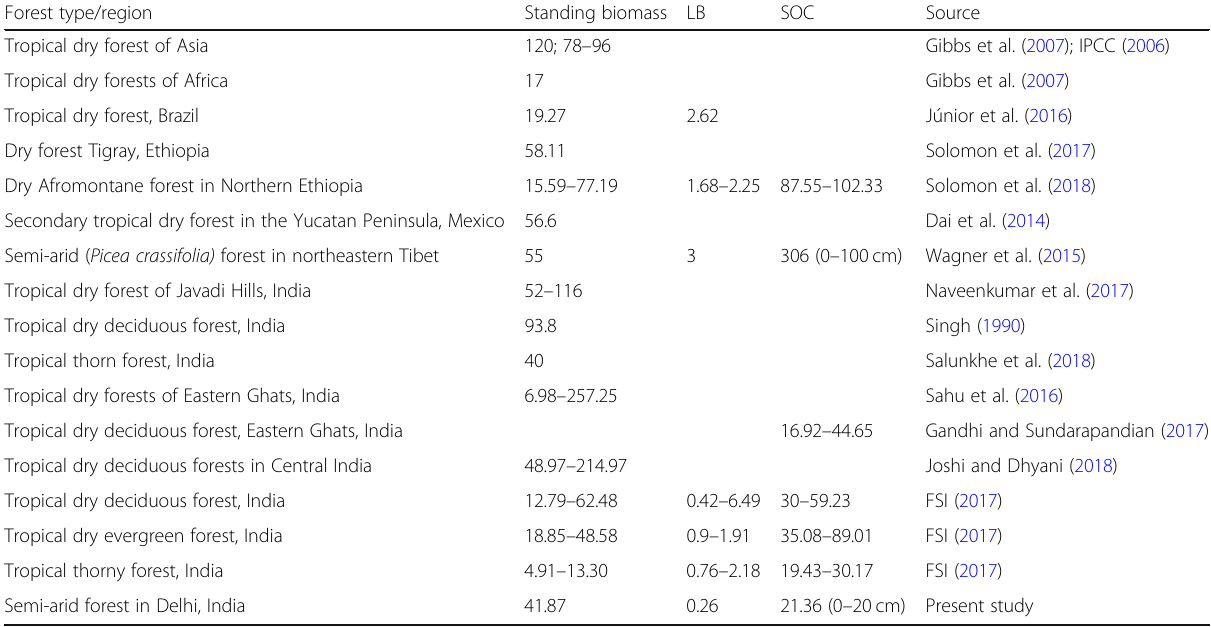
Table 6 Comparison of carbon content (Mg C ha − 1 ) in standing biomass, litter, and soil of dry forests Forest